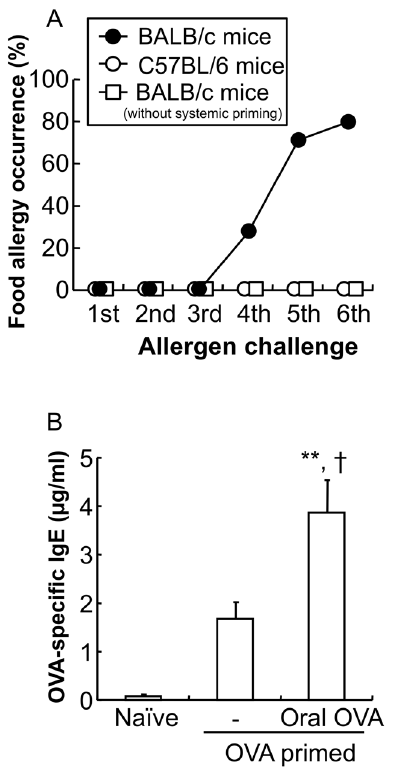
Figure 1. Induction of Th2-mediated food allergy. The allergic responses were induced by two instances of systemic OVA priming and repeated oral OVA (50 mg) challenges. A : Systemically primed BALB/c mice (closed circle) and C57BL/6 mice (open circle) and non- systemically primed BALB/c mice (open square) were subjected to food allergy (FA)-inducing oral OVA challenges ( n =5–8 mice per group). B : The level of OVA-specific IgE in the plasma of naı¨ve mice, systemically primed mice, and systemically primed and repeated oral OVA challenged mice is shown. The level of OVA-specific IgE in the plasma was determined using an ELISA kit. Data are expressed as means 6 SE. ** P , 0.01 vs. naı¨ve mice. { P , 0.05 vs. systemically primed mice ( n =5 mice per